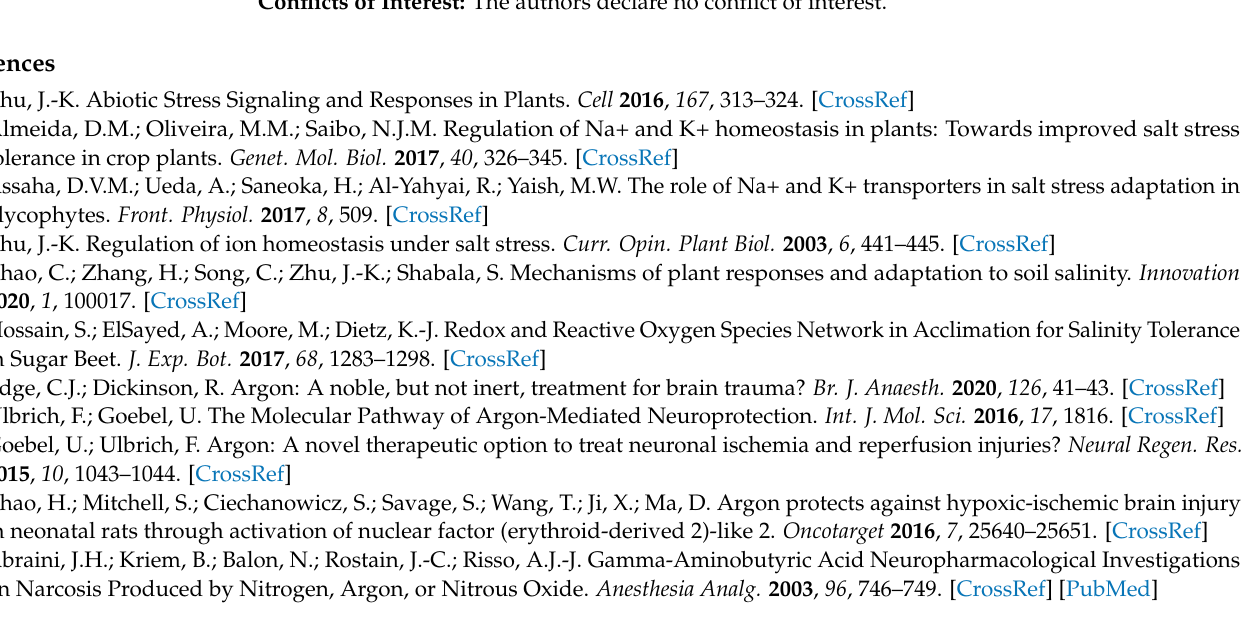
Table S2: Effects of argon-rich water (ARW) on germination parameters upon NaCl stress; Table S3: Effect of nitrogen-rich water (NRW) on germination percentage upon NaCl